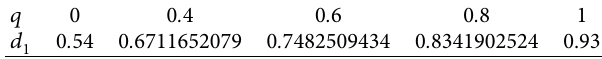
corresponding to q. 1